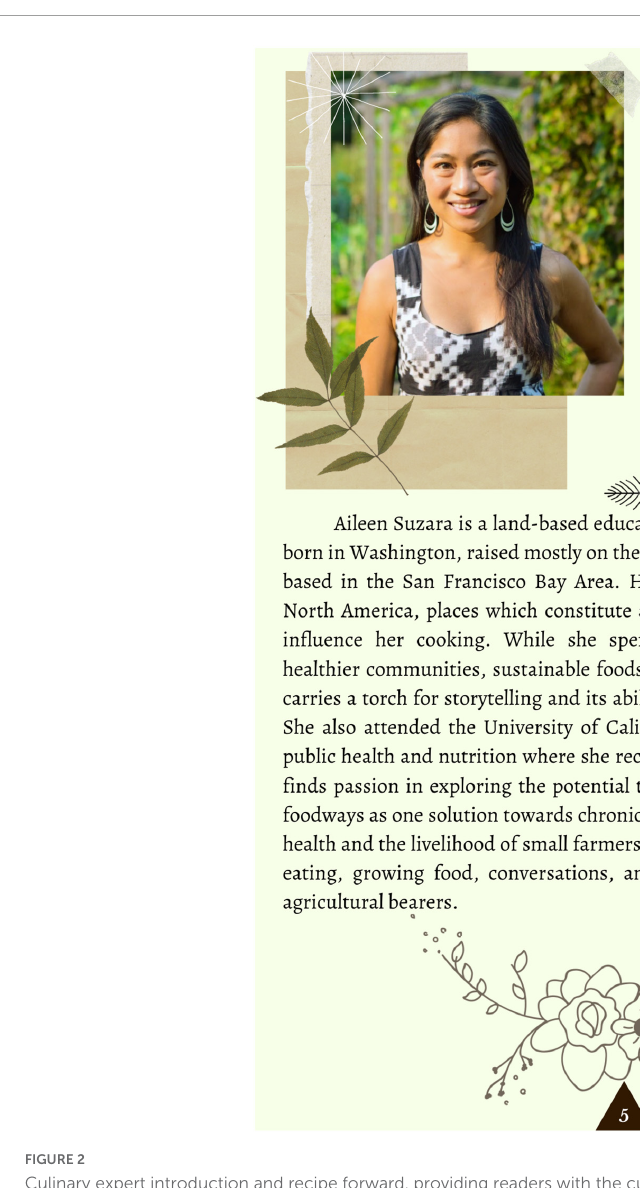
confidence, and management for persons with hypertension,